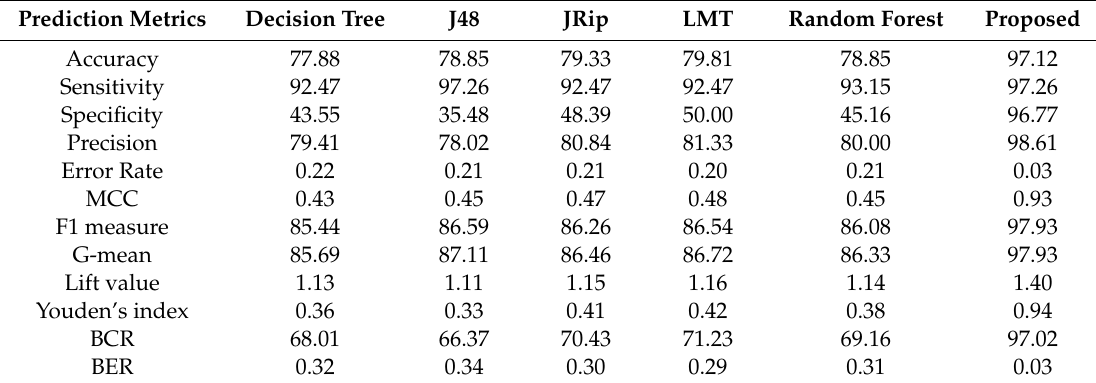
Table 7. GLCM_45